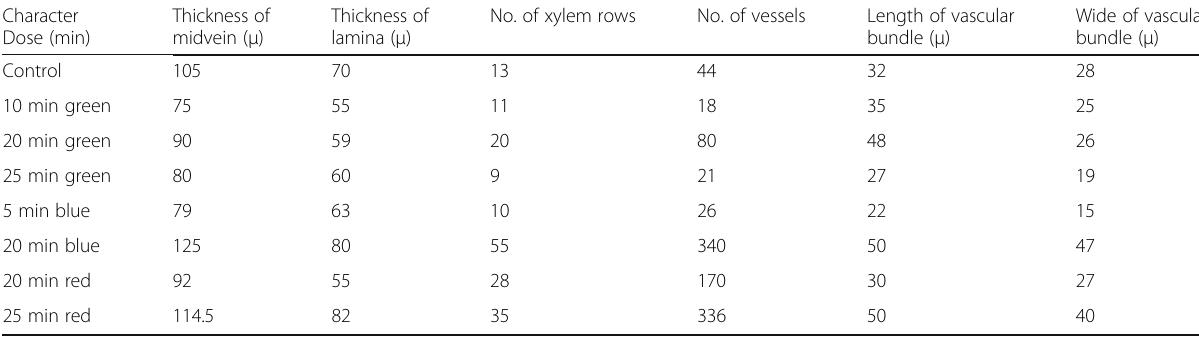
Wide of vascular bundle ( μ ) bundle ( μ )